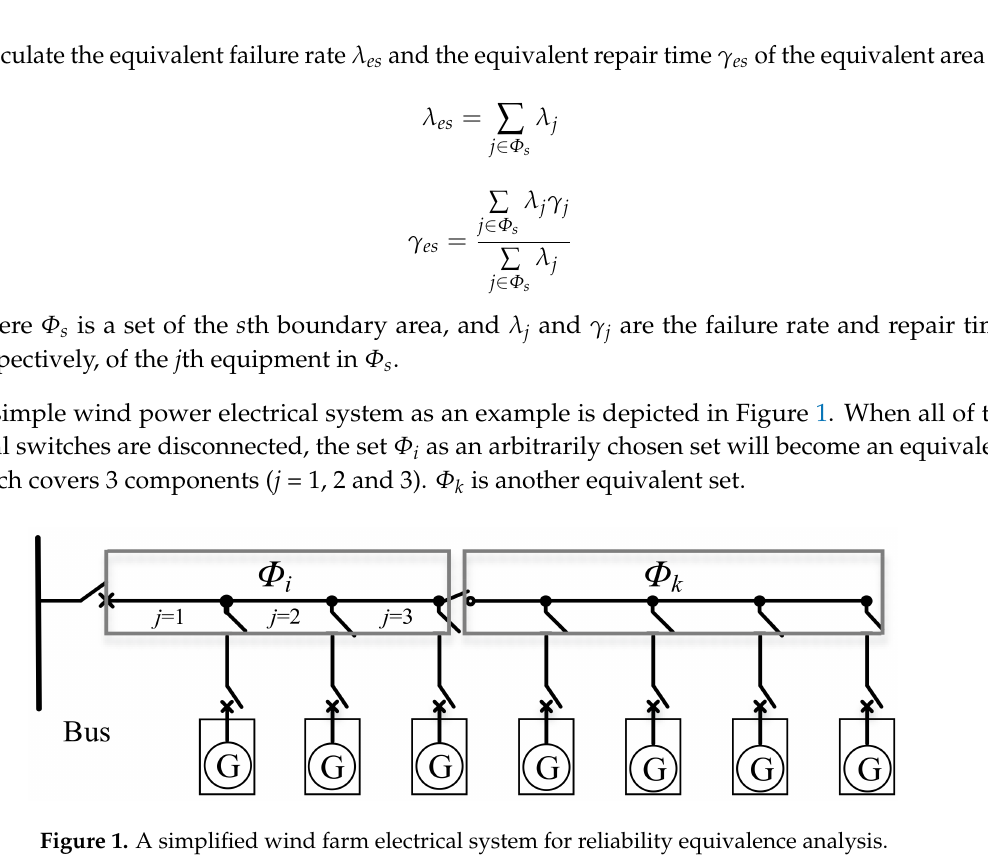
Figure 1. A simplified wind farm electrical system for reliability equivalence analysis.